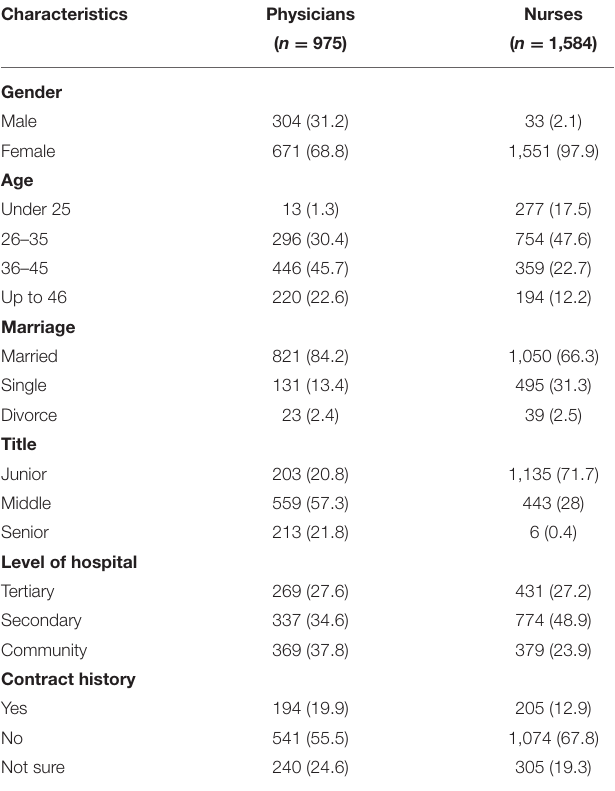
TABLE 1 | The characteristic of